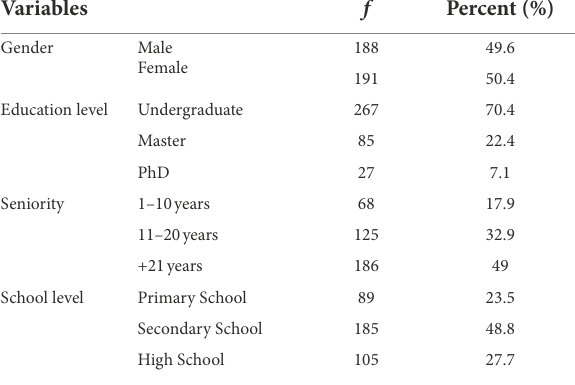
TABLE 1 Demographic characteristics of the